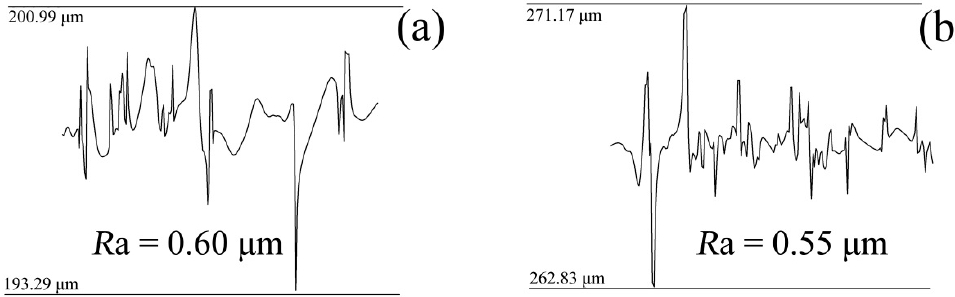
Figure 4. The roughness of original mold: ( a ) scheme 1; ( b ) scheme 2.